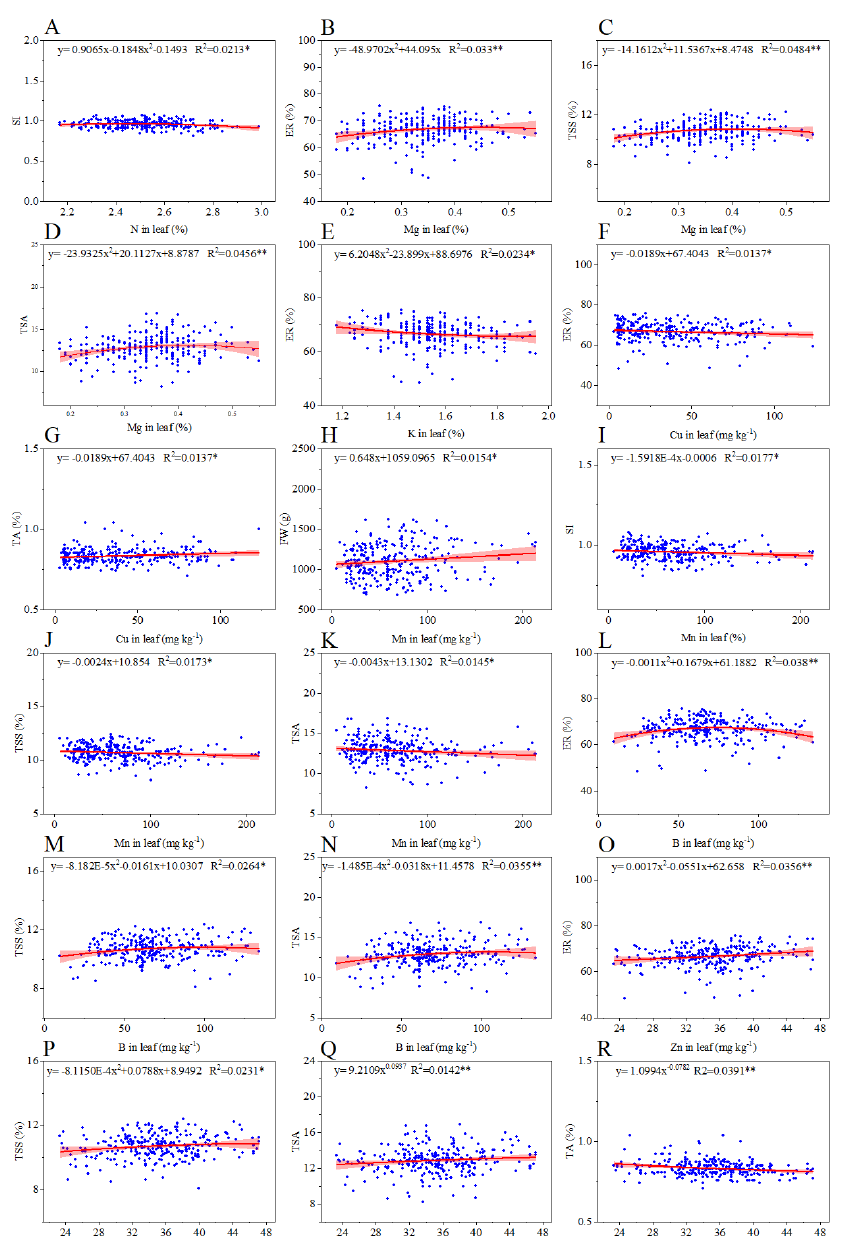
Figure 4. Response curves of leaf nutrient contents ( X -axis) versus different fruit quality ( Y -axis) in pomelo ( n = 281). FW: Single fruit weight; SI: Fruit shape index; ER: Edible rate; TA: Titratable acidity; TSS: Total soluble solids; TSA: Total soluble solids/Titratable acidity. ( A ) N, ( B ‒ D ) Mg, ( E ) K,